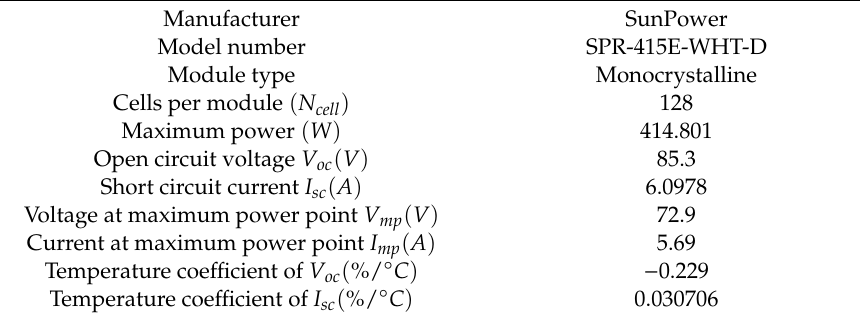
Table 1. Photovoltaic (PV) module data used in the